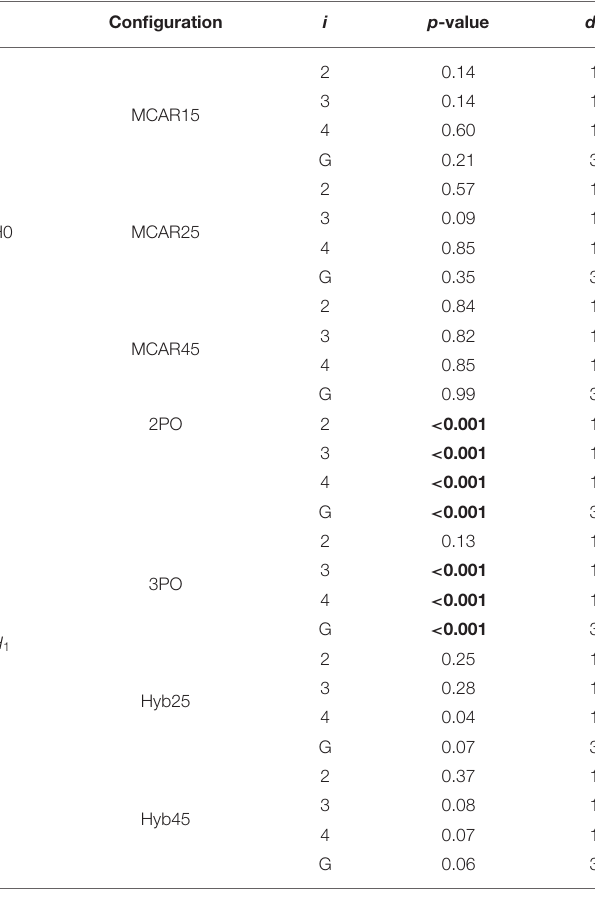
TABLE 6 | Using different configurations of the Canada geese dataset to assess the performance of the new mixture test for assessing the underlying state structure of partial observations, under real-life